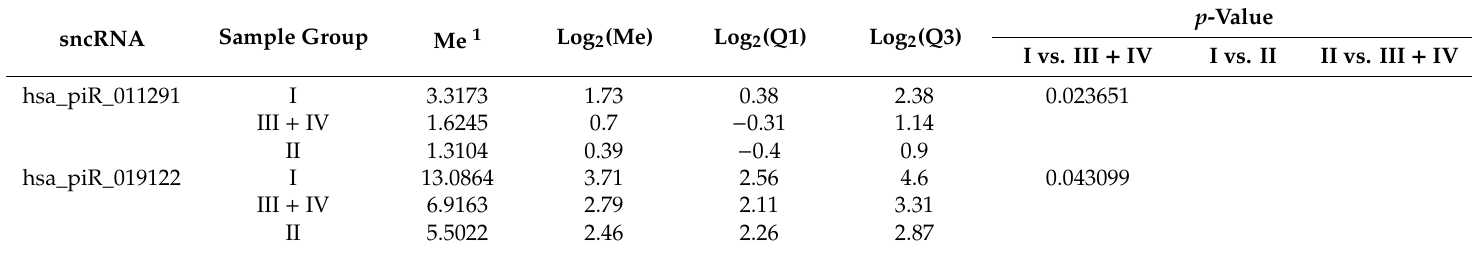
Table 4. Pairwise comparison of morula groups (I–IV) with di ff erent developmental potential according to the fold change in the detection level of sncRNAs in spent culture medium assessed by